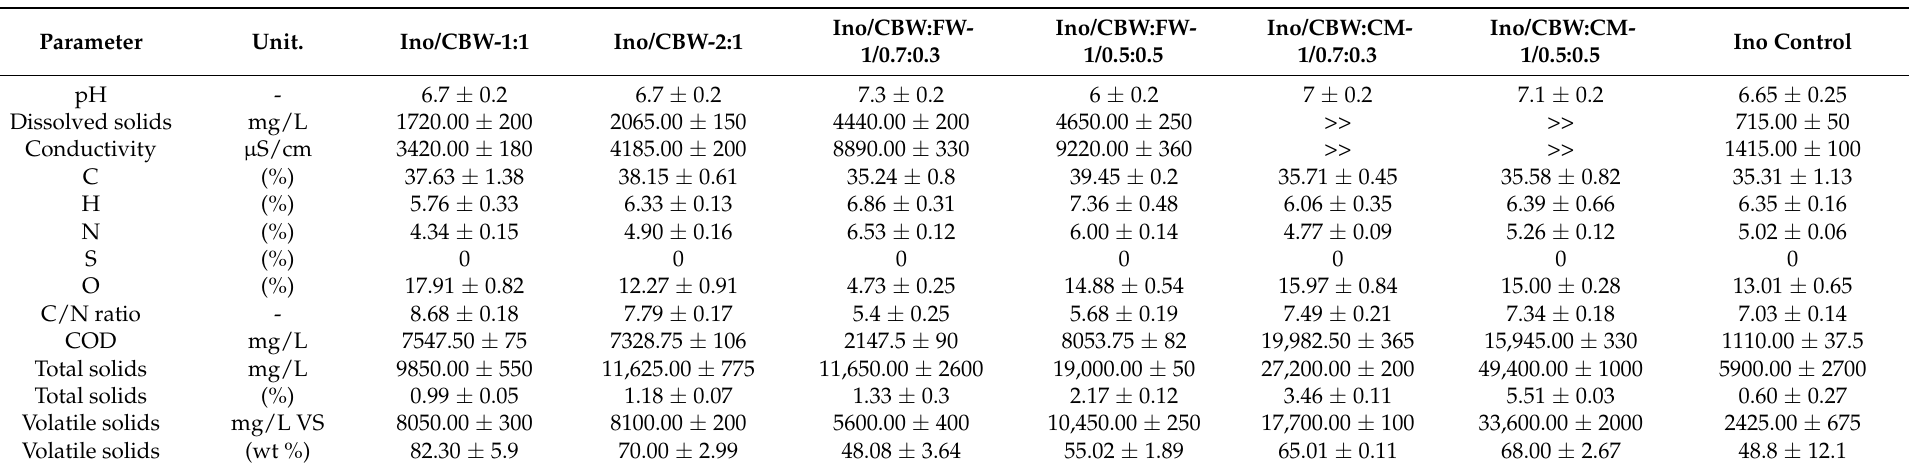
Table 2. Characterization of the digestate of the different